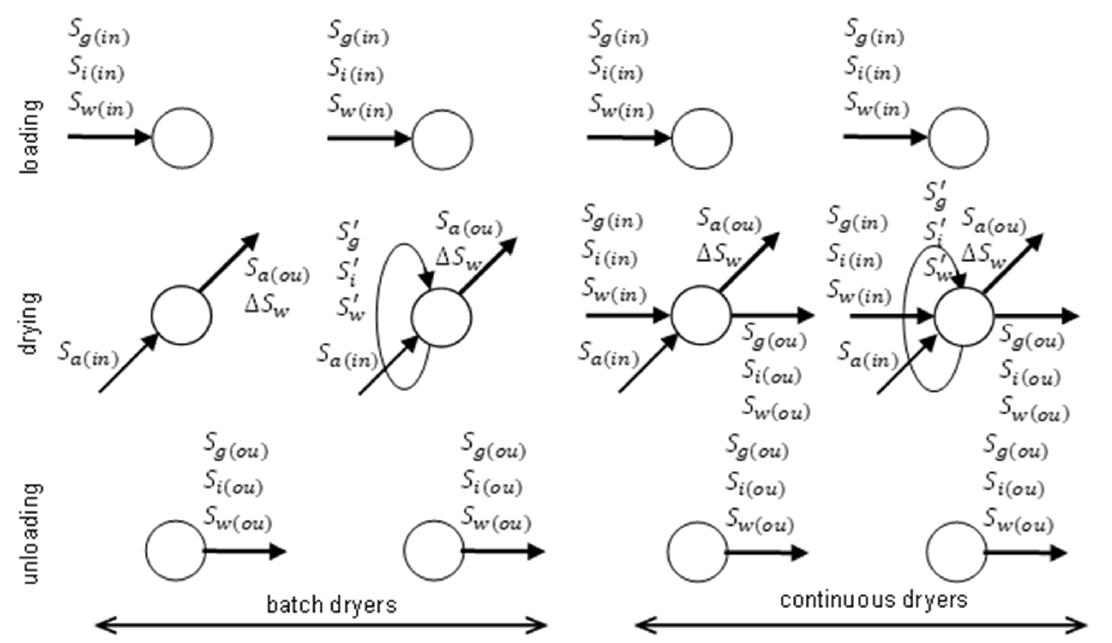
Figure 2. Operations performed by batch dryers and continuous-flow dryers.